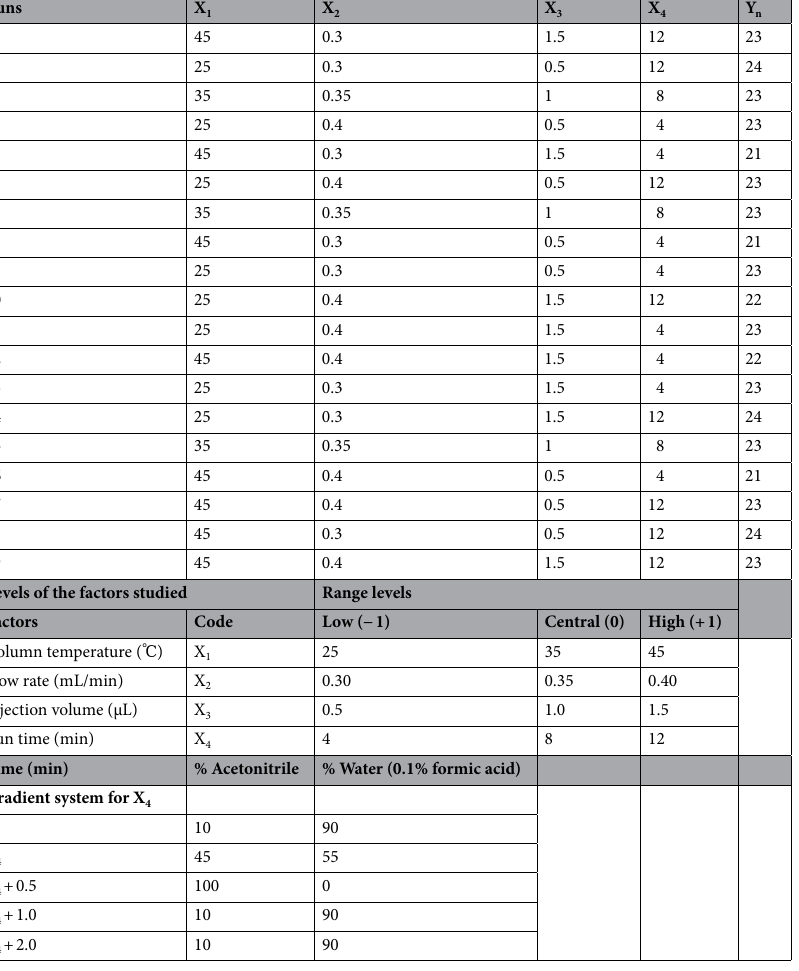
Table 3. 4 2 -Full factorial design (FFD) matrix for factor screening and the studied responses. Y n peak